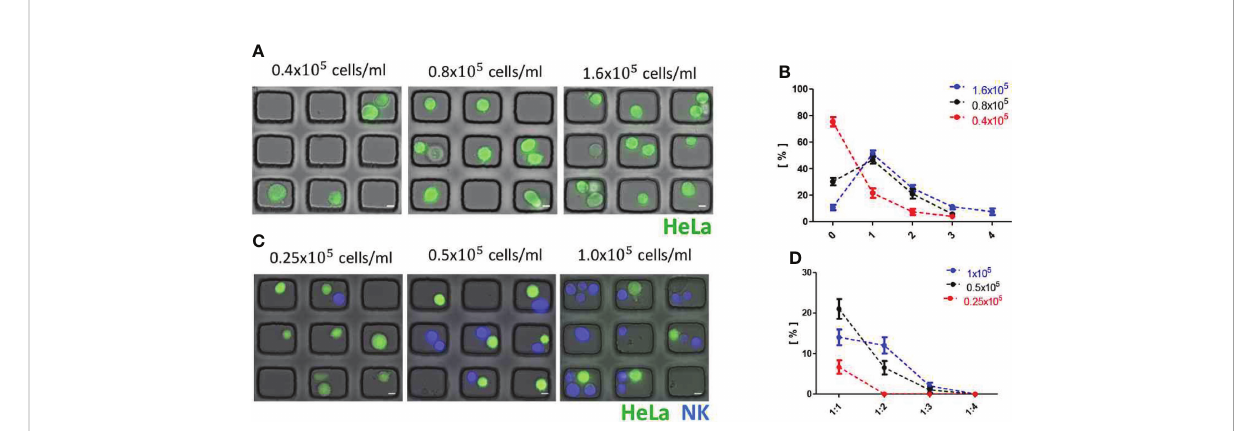
FIGURE 4 Optimization of one-to-one cell pairing in microwells. (A) DIC/ fl uorescence overlay images of HeLa cell (green)-loaded microwell arrays with various seeding density of HeLa cells. Scale bars: 10 m m. (B) Distributions of cancer cell number/microwell. (C) DIC/ fl uorescence overlay images of HeLa cell (green)-NK-92 cell (Blue) loaded microwell arrays with fi xed cell seeding density of HeLa cells (0.8 × 10 5 /ml) and various cell seeding density of NK-92 cells. Scale bars: 10 m m. (D) Distribution of tumor:NK ratio/microwell. All data representative of three independent